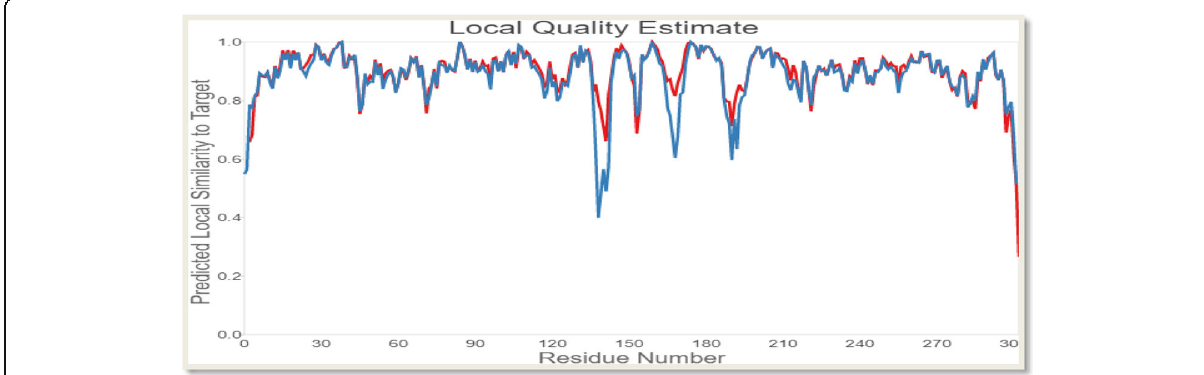
Fig. 6 Local quality estimate graph showing the values of the predicted local similarity to target ( y -axis) plotted against the protein residue number ( x -axis). This quality estimation was carried out on both chains of the target protein with the red and blue lines representing chains A and B, respectively